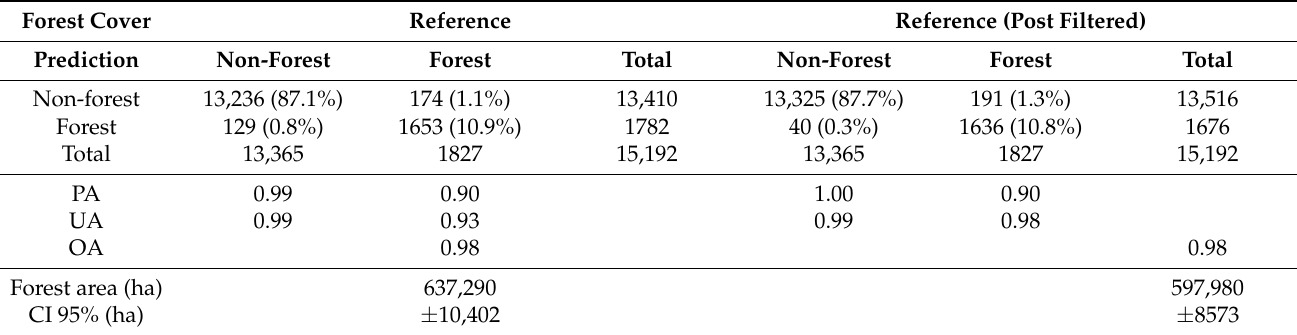
Table 2. Confusion matrix and producer (PA), user (UA), and overall (OA) accuracy statistics for the raw forest cover classification (left) as well as for the post-filtered forest cover classification (right) based on the independent evaluation data. Entries in the matrix represent the number of pixels and proportions in brackets. Post filtering included the removal of forest areas smaller than the minimum mapping unit (0.5 ha) and forest in low build-up areas. The resulting forest areas and 95% confidence intervals (CI 95%) are based on the good practice for error-adjusted area estimation